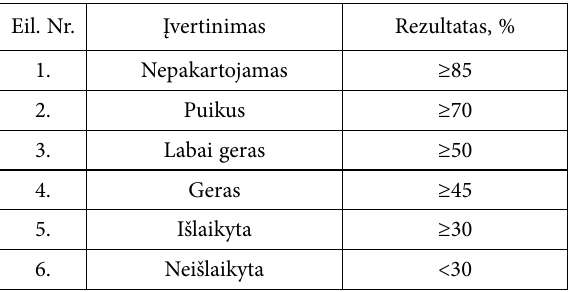
Table 2. Assessment results (BREEAM 2010) Eil.